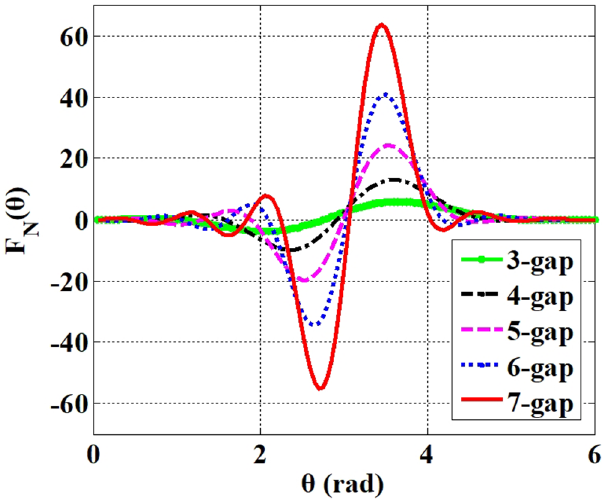
Fig. 6. Power exchange function F N ( u ) versus gap transit angle u ( u = b L , b is the phase constant and L is the period), also, F < 0 and F u ) > 0 stand for the status of oscillation and N ( ampli fi cation, respectively [64].